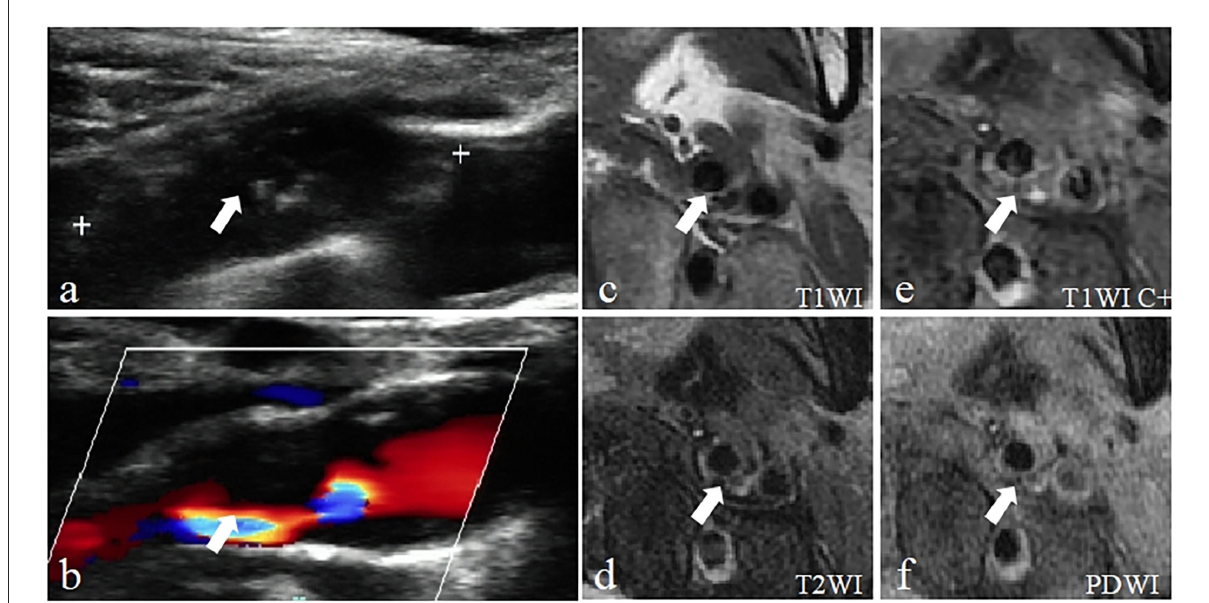
FIGURE4 Example of a vulnerable carotid plaque of a patient using Carotid ultrasound (CDU) and High-resolution magnetic resonance imaging (HRMRI). (a) Gray-scale longitudinal section scan shows heterogeneous plaques in the posterolateral wall of the left carotid bulb extended to the internal carotid artery with a large hypoechoic area inside (arrow). (b) CDFI longitudinal section scan showed that blood flow signals were visible in the residual lumen (arrow). (c) The plaque is characterized by the isointensity on T1-weighted imaging (T1WI) (arrow). (d) T2-weighted imaging (T2WI) showing slightly high signal intensity (arrow). (e) Enhanced T1-weighted imaging (T1WI C + ) showing regional enhancement within the AP (arrow), defined as neovascularization or inflammation, indicate the plaque is more likely to be vulnerable. (f) Proton density-weighted imaging (PDWI) showing slightly high signal intensity within the AP (arrow).